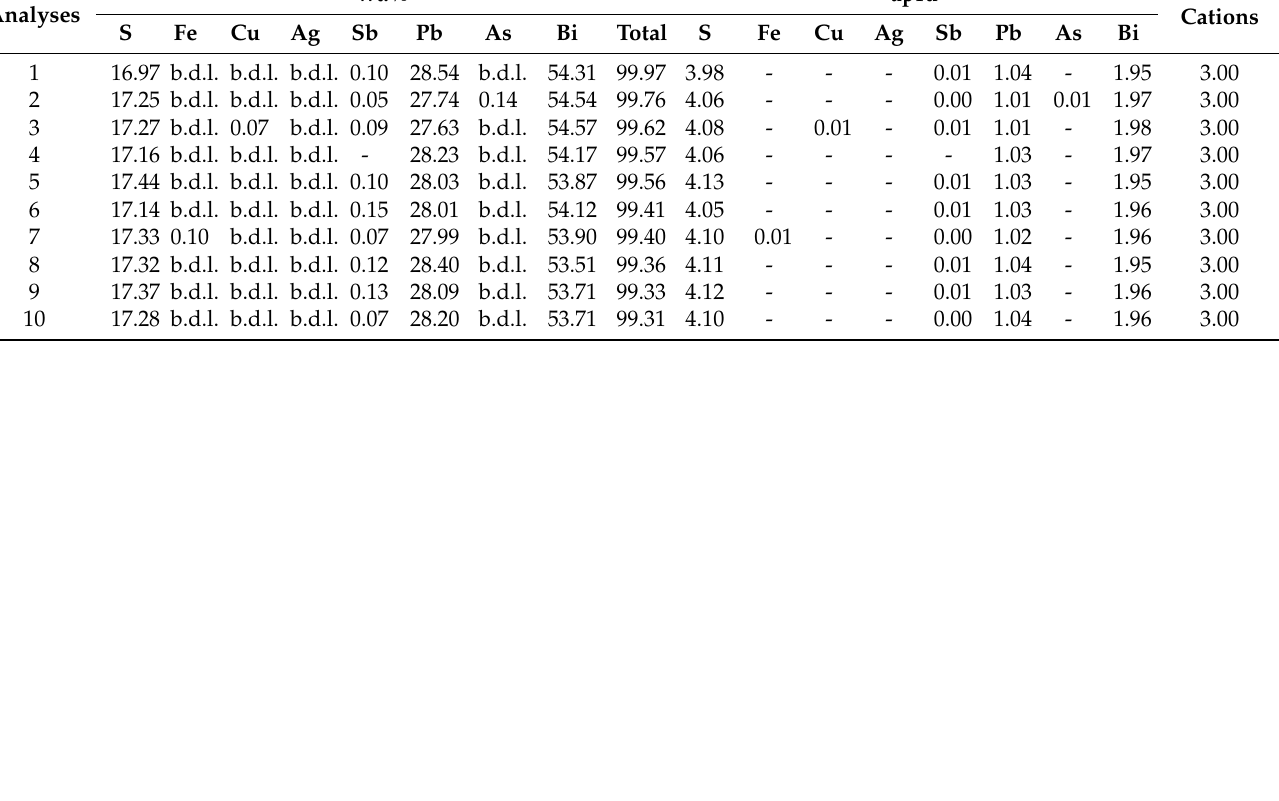
Table 8. Representative EPMA data for galenobismutite from the Kizhnica hornfels. The empirical formula was calculated based on 3 cations, b.d.l. = below detection limit.